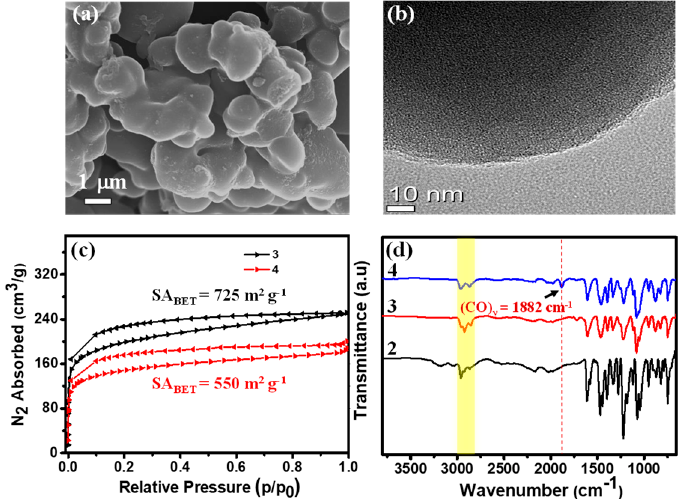
Figure 1. ( a ) SEM image of POP-Pc’CrCl, ( b ) TEM image of 3 , ( c ) N 2 sorption isotherms of 3 and 4 at 77 K, and ( d ) FTIR spectra of 2 , 3 , and 4 .